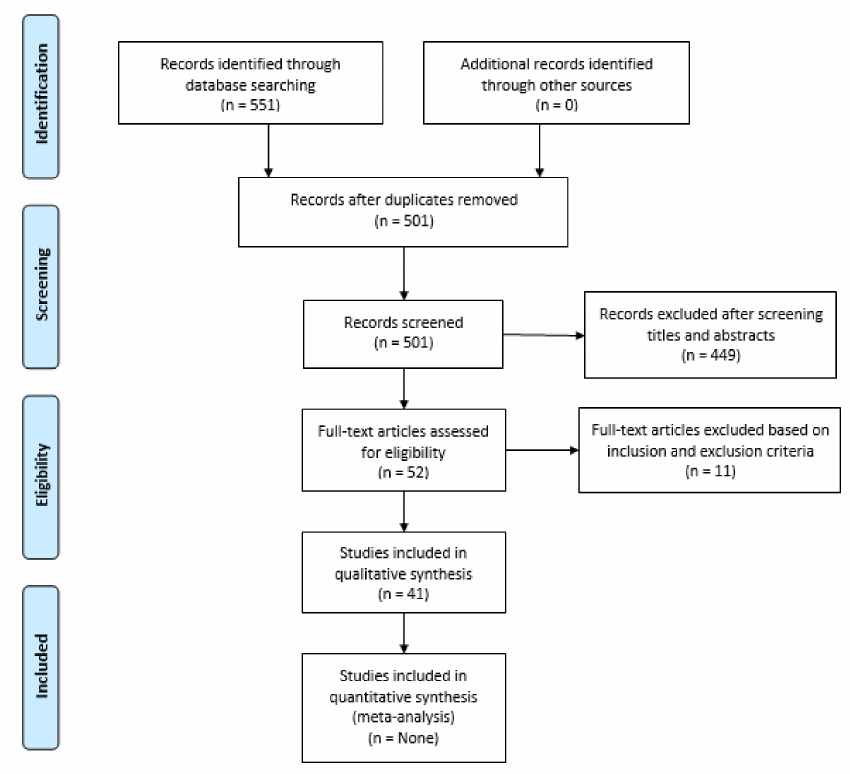
Figure 1. PRISMA flow diagram depicting the flow of information through the different phases of a systematic